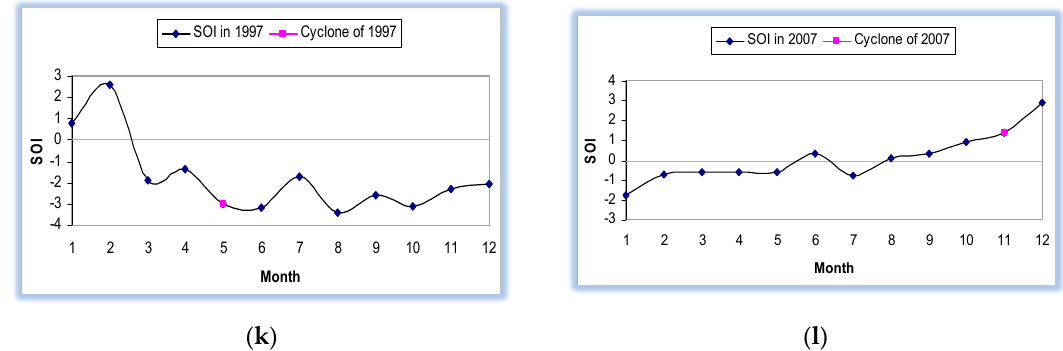
Figure 3. Twelve major cyclones ( a ) 1960, ( b ) 1961, ( c ) 1963, ( d ) 1965, ( e ) 1970, ( f ) 1974, ( g ) 1985, ( h ) 1988, ( i ) 1991, ( j ) 1994, ( k ) 1997, ( l ) 2007 over Bangladesh under ENSO phase. Black line represents the variability of SOI, and green line is the base line where positive value (>0.5) of SOI indicates El Niño, negative value (< − 0.5) indicates La Niña, and rest ( − 0.5 to 0.5) shows the neutral ENSO phase. Magenta dot indicates the month of the year when cyclone started.